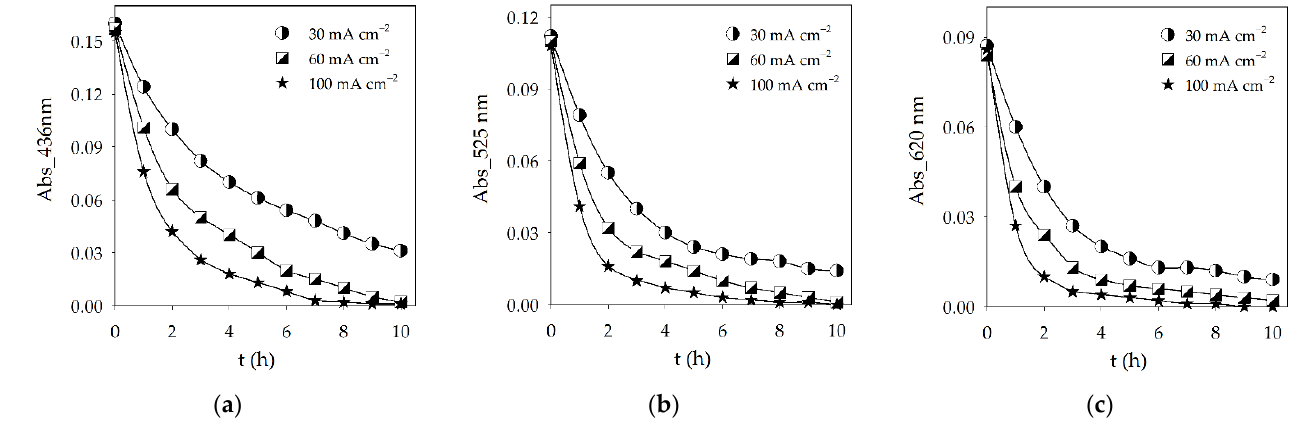
Figure 3. Decay in time of absorbance at ( a ) 436 nm; ( b ) 525 nm; and ( c ) 620 nm, during the prelim- inary EO experiments performed at different j